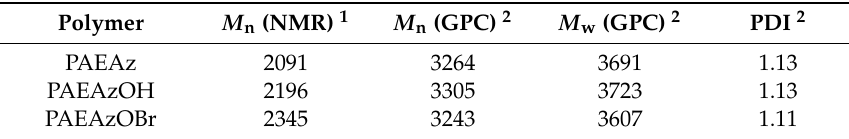
Figure 1. 1 H NMR spectra of ( a ) PAEAz. ( b ) PAEAzOH. ( c ) PAEAzOBr in THF- d 8 . Table 1. Molecular weights and PDI of the PAEAz Table 1. Molecular weights and PDI of the PAEAz derivatives.